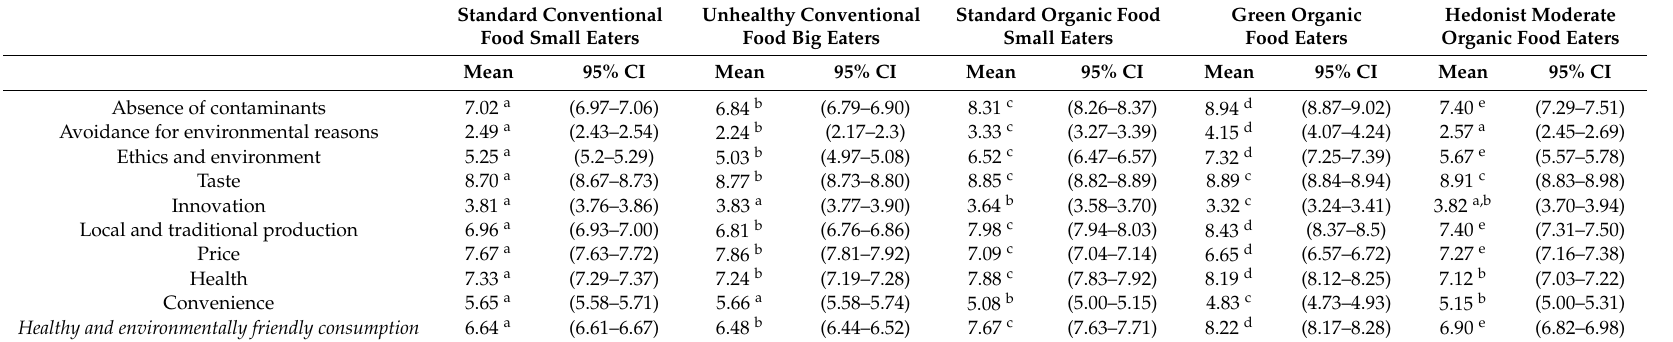
Table 5. Mean food choice dimension scores across clusters of consumers, NutriNet-Santé Study, n = 22,966 1,2